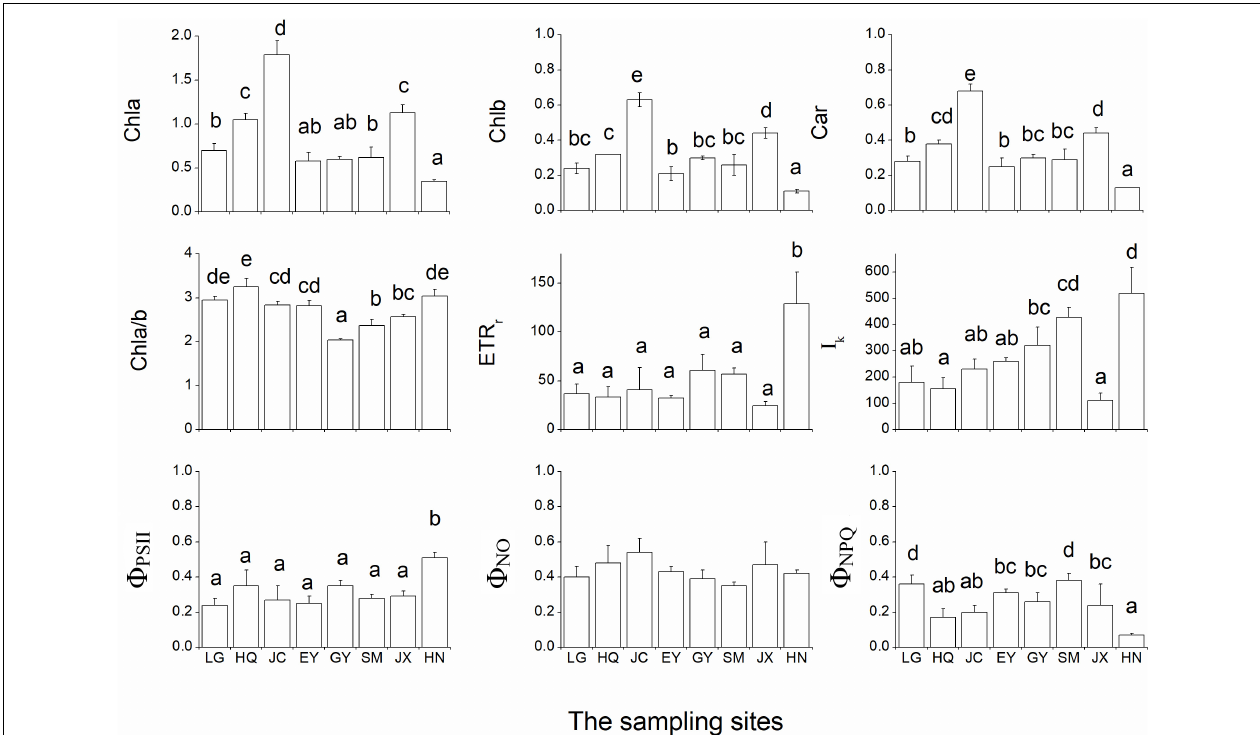
FIGURE 4 | The nine pigment-related leaf traits in the eight populations. Chla, Chlb, Car, and Chla/b refer to the leaf chlorophyll a (unit: mg g − 1 FW), chlorophyll b (unit: mg g − 1 FW), carotenoids (unit: mg g − 1 FW) and the ratio of Chla and Chlb, respectively. rETR max (unit: µ mol electron m − 2 s − 1 ), I k ( µ mol photon m − 2 s − 1 ) , (cid:56) (cid:56) (cid:56) PSII , NPQ and NO are five leaf chlorophyll fluorescence parameters in the inductive curve and rapid light curve. The different letters in the figure indicate the significant difference among the eight population.